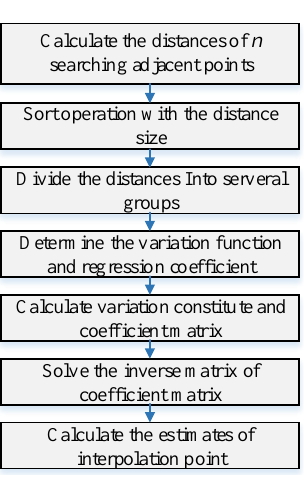
Figure 2. Main steps of the universal kriging interpolation function.